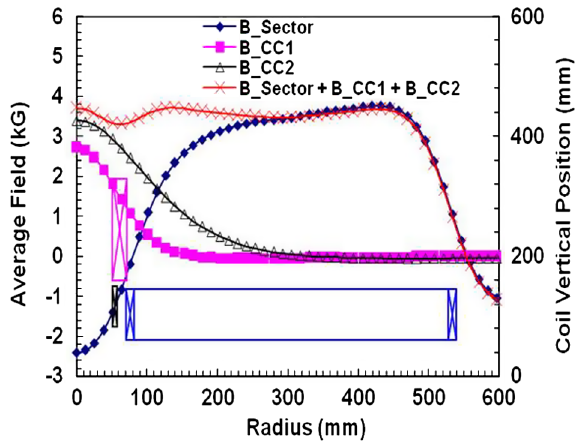
FIG. 7. Average magnetic field for the sector coils and two central coils (CC1 and